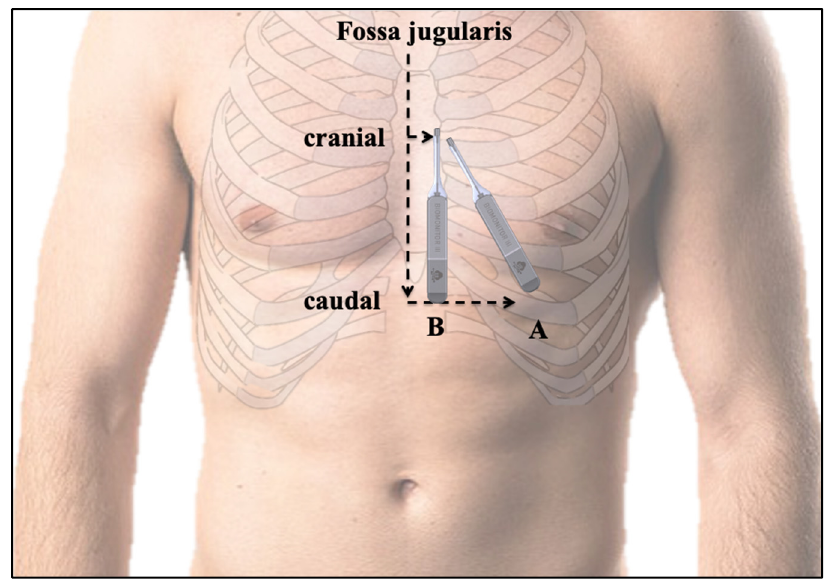
Figure 2. Anatomical position of the BIOMONITOR III : (A) Recommended and (B) alternative anatomical positions of the BIOMONITOR III in the present study.